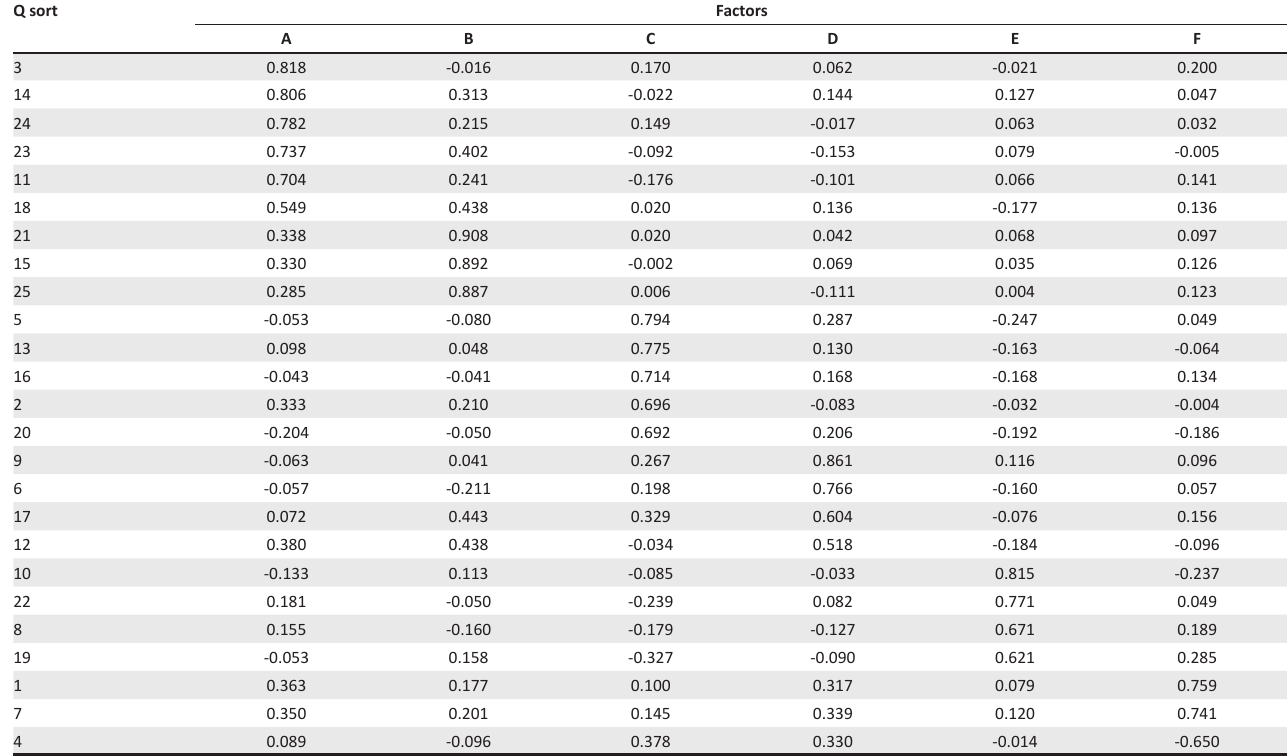
TABLE 4: Factor loading